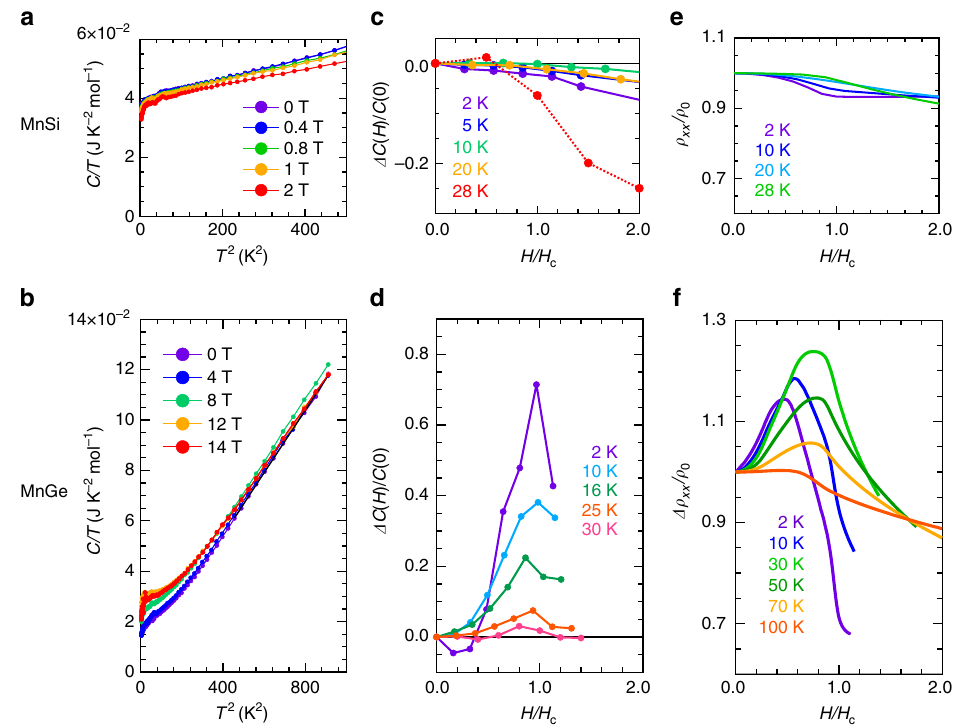
Fig. 3 Speci fi c heat and magneto-resistivity in MnGe and MnSi. Speci fi c heat and magneto-resistivity for MnSi ( a , c , e ) and MnGe ( b , d , f ). a , b C / T plotted against T 2 under various magnetic fi elds. C is the speci fi c heat. c , d Change in the speci fi c heat Δ C ( H ) as a function of external magnetic fi eld normalized by the critical fi eld H c at respective temperatures. MnGe shows a sharp enhancement at the topological phase transition ( H / H c = 1.0). e , f Magneto-resistivity normalized by the value at zero fi eld at respective temperature. Large positive anomaly observed in MnGe ( f ) is attributed to the fl uctuations of emergent magnetic fi eld (monopole fl